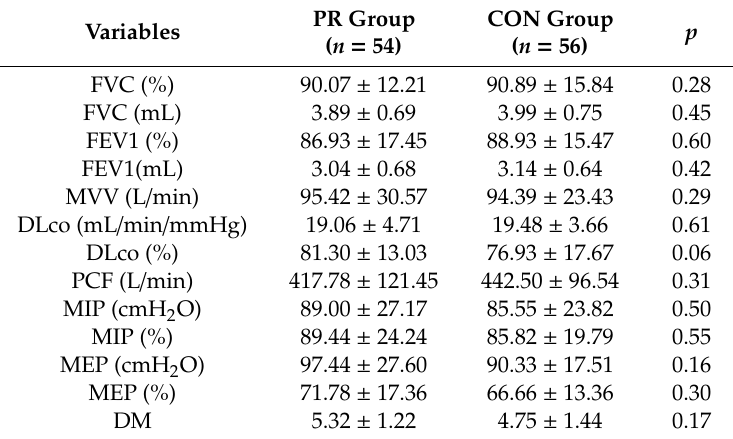
Table 2. Pulmonary function measurements at